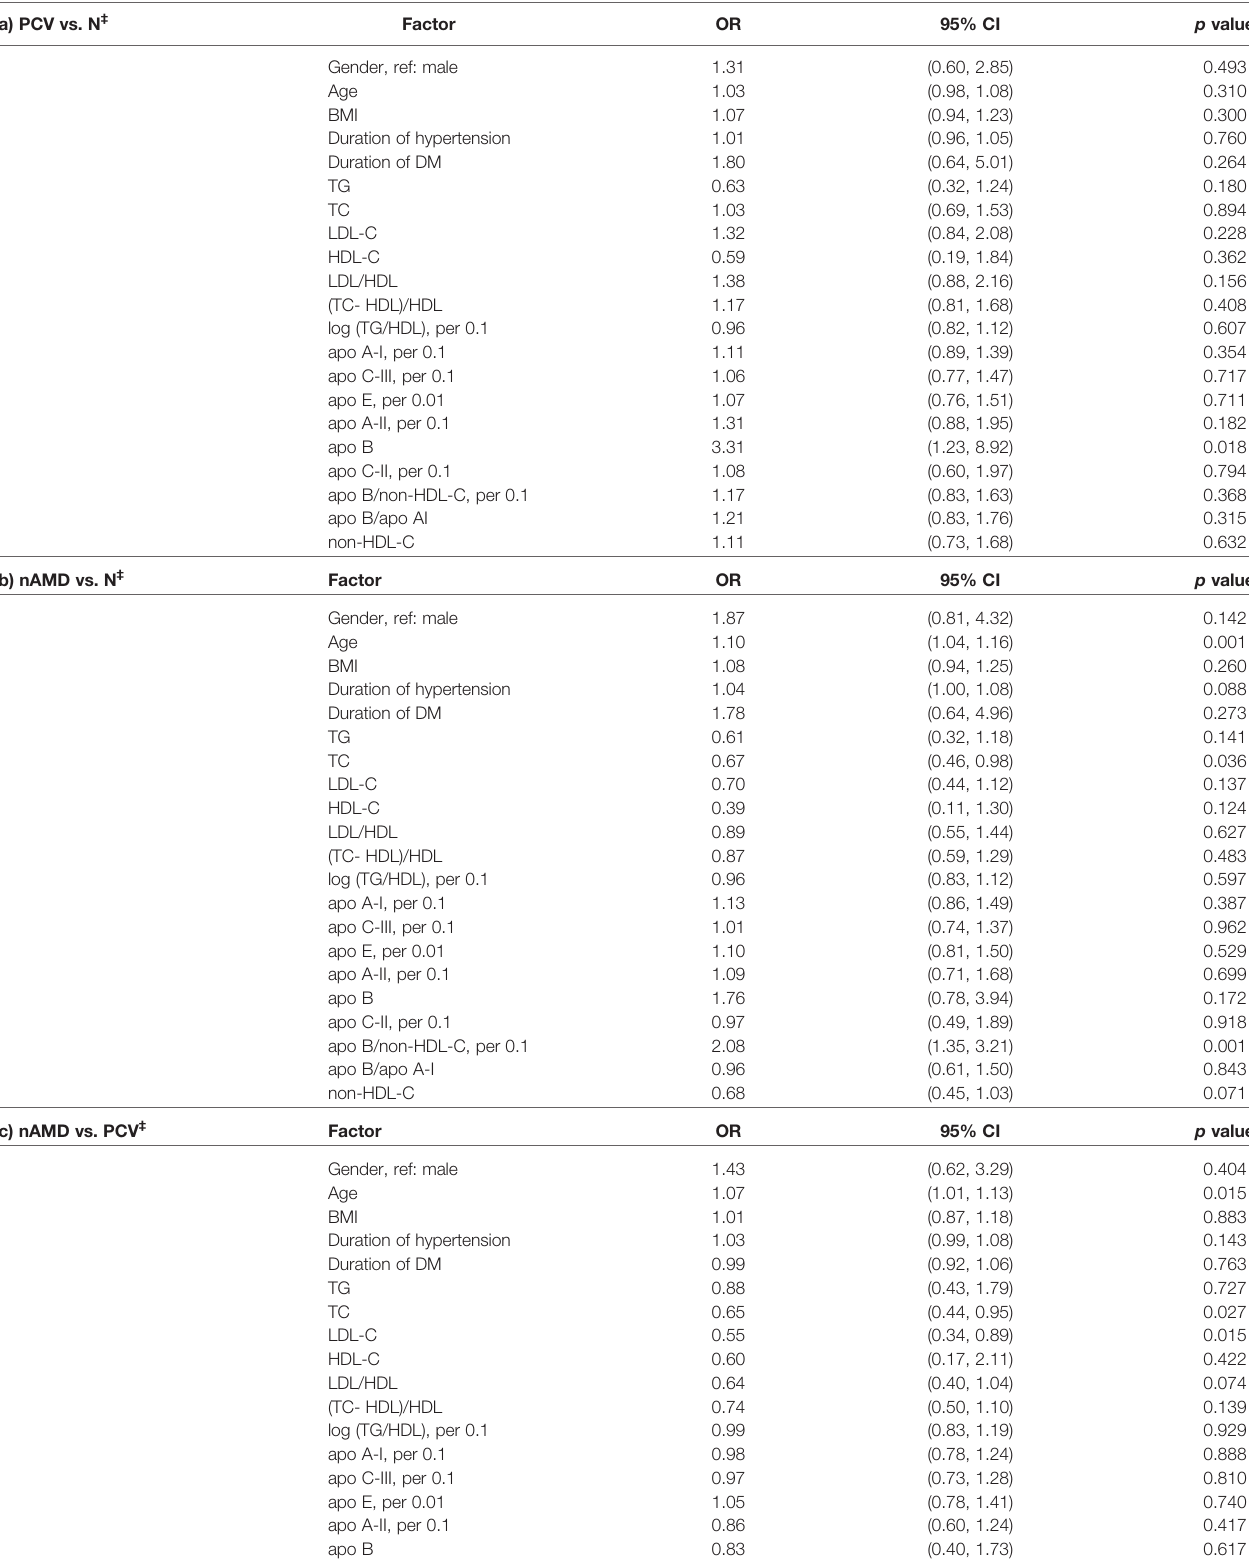
TABLE 2 | Comparisons of the variables between PCV, nAMD and control groups by univariate logistic regression analysis. (a) PCV vs. N